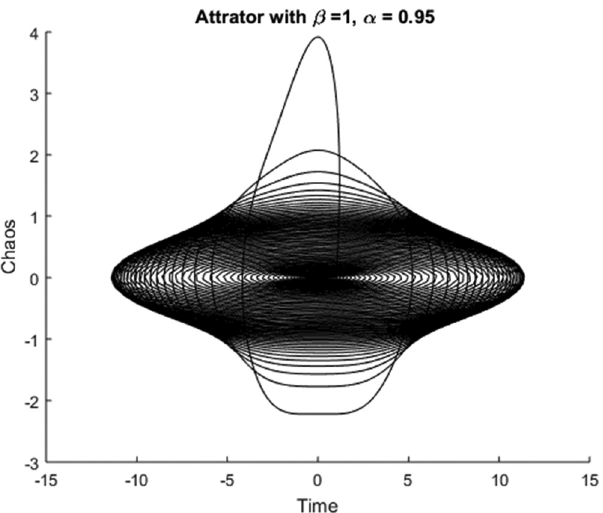
Figure 4: Chaos with exponential decay